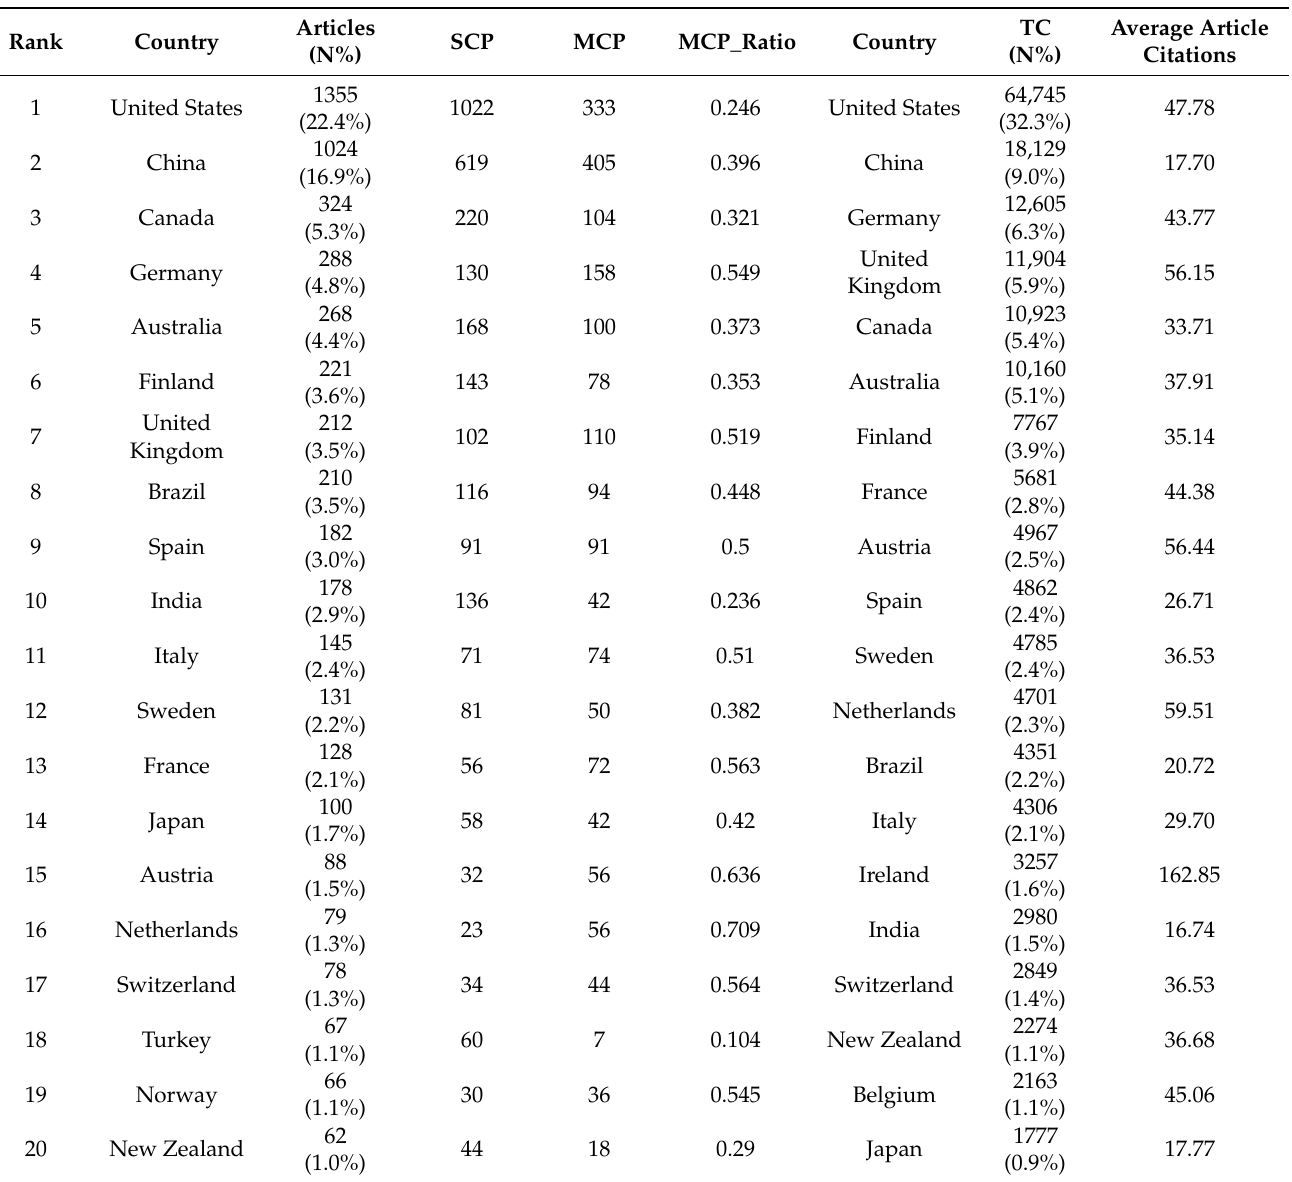
Table 2. The 20 countries or regions with the highest total number of research papers published and the highest total number of citations in the study from